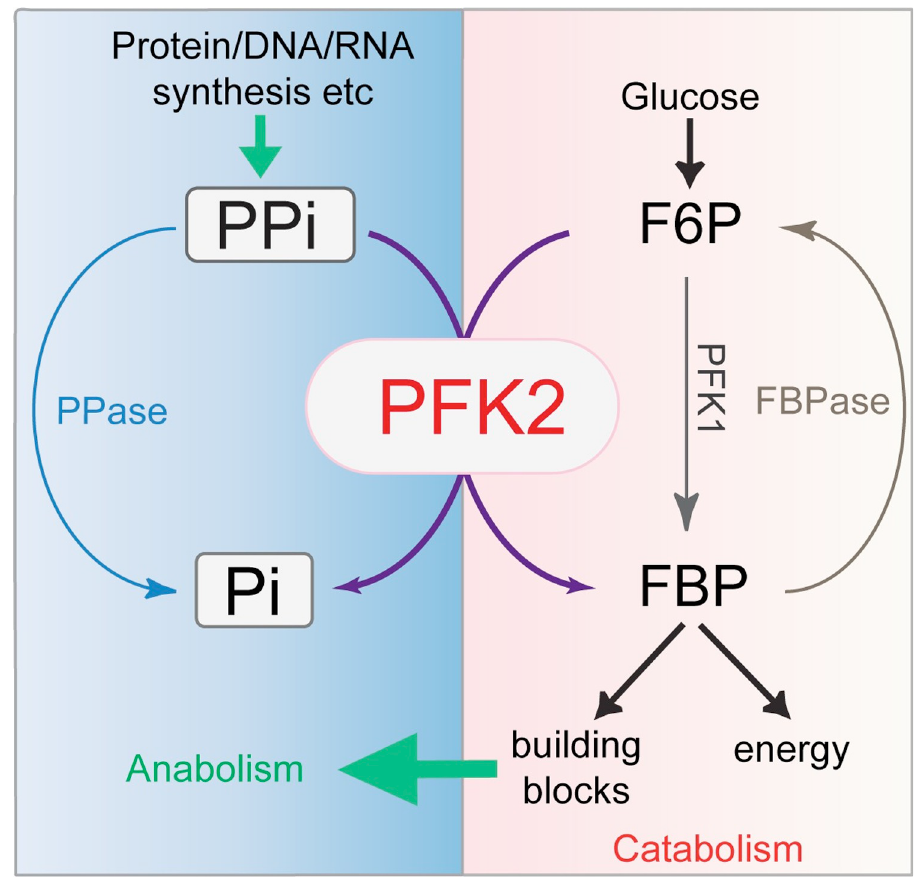
Fig 8. A model for PFK2 in maintaining PPi homeostasis and balanced catabolism and anabolism in Toxoplasma . The biosynthesis of macromolecules such as proteins, DNA and RNA generates PPi, which is then converted to Pi by PPase and the PPi-dependent phosphofructokinase PFK2. The hydrolysis of PPi by PFK2 is coupled to the phosphorylation of F6P to FBP, the committed step of glycolysis. Through the activity of PFK2, PPi is hydrolyzed, which otherwise would inhibit biosynthetic reactions. In addition, glycolysis is activated to produce more building blocks for macromolecule synthesis as well as energy. As such, PFK2 serves as a key factor in coordinating the parasites’ catabolic and anabolic activities. PFK2-deficient parasites suffer from increased levels of PPi, reduced macromolecule biosynthesis and decreased glycolysis. PFK1 may be able to rescue in part the defects in glycolysis caused by PFK2 depletion, but it would not be able to reverse the defects in PPi homeostasis and macromolecule synthesis. This may be due to that DNA synthesis is less sensitive to PPi than protein synthesis. For instance, when we do PCR reactions in test tubes, we never add any pyrophosphatase to remove PPi. Or, as a recent study reported, PPi hydrolysis may be an intrinsic step of the DNA synthesis reaction catalyzed by DNA polymerases [49]. Nonetheless, neither explanation can explain the discrepancy in cell cycle alteration between IPP1 suppression in yeasts and PFK2 depletion in Toxoplasma . PPase and PPi-PFKs may work differently although both can con- sume PPi. Indeed, both the cytosolic PPase and PPi-PFK (PFK2) are critical, instead of redun- dant or synthetic lethal, for the growth of tachyzoites. On the other hand, the partial rescue of PFK2 mutants by PPase suggests that they do have overlapping functions. Interestingly, we showed that PFK2-N had full PPi-PFK activity as the full-length PFK2 enzyme (Fig 1E). Yet it was not able to complement the PFK2 depletion mutant (Fig 7), suggesting additional roles of PFK2 besides the PPi-PFK enzymatic activity and they deserve further investigations.